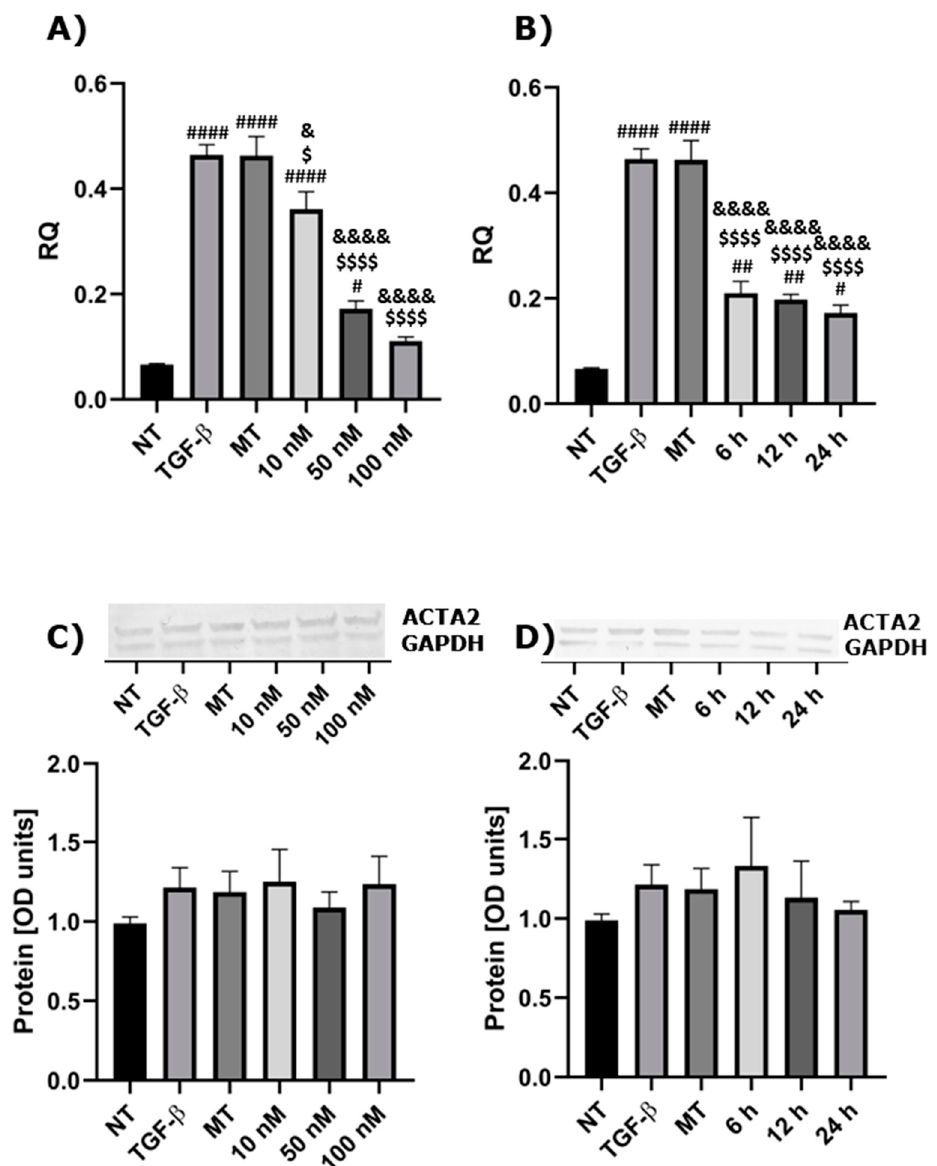
Figure 1. Calcitriol inhibits the expression of ACTA2 in dose- or time-dependent manner. ( A ) mRNA expression and ( C ) protein level of ACTA2 after pre-treatments with three chosen concentrations of 1,25(OH) 2 D 3 and treatment with 10 ng/mL of TGF- β . ( B ) mRNA expression and ( D ) protein level of ACTA2 after pre-treatments with 1,25(OH) 2 D 3 for three chosen incubation times and treated with 10 ng/ml of TGF- β . The results of experiments (n = 3) are presented in relation to GAPDH as a mean ± SEM. Western blots are shown for genes, in which the statistical significance has been observed at the mRNA level. Original Western blots can be found at Figure S1. # p < 0.05, ## p < 0.01, #### p < 0.0001 versus NT group; $ p < 0.05, $$$$ p < 0.0001 versus TGF- β group; & p < 0.05 and &&&& p < 0.0001 versus MT group. One-way analysis of variance (ANOVA) or Kruskal-Wallis test followed by corresponding post hoc was used to determine differences in several groups, and Student’s t -test or Welch’s t -test was used to determine statistically significant differences between two means. RQ—relative quantification of genes expression normalized to GAPDH, NT—non-treatment cells, TGF- β —cells treated with TGF- β , MT—cells treated with 0.1% of methanol and TGF- β